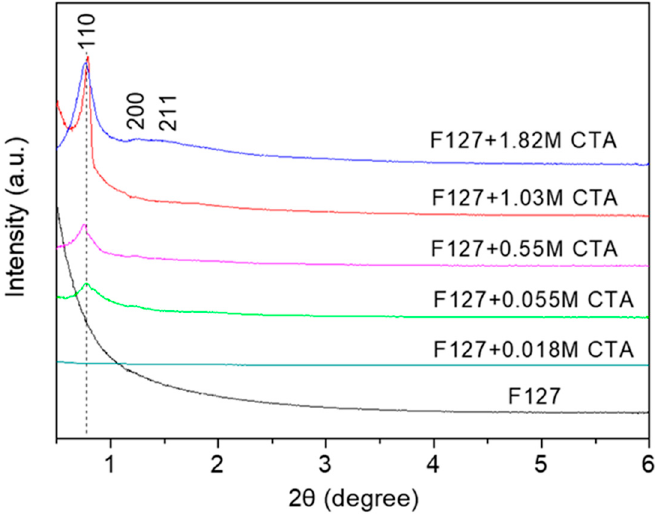
Figure 4. Small ‐ angle XRD patterns of the calcined HMS samples. Figure 4. Small-angle XRD patterns of the calcined HMS samples.